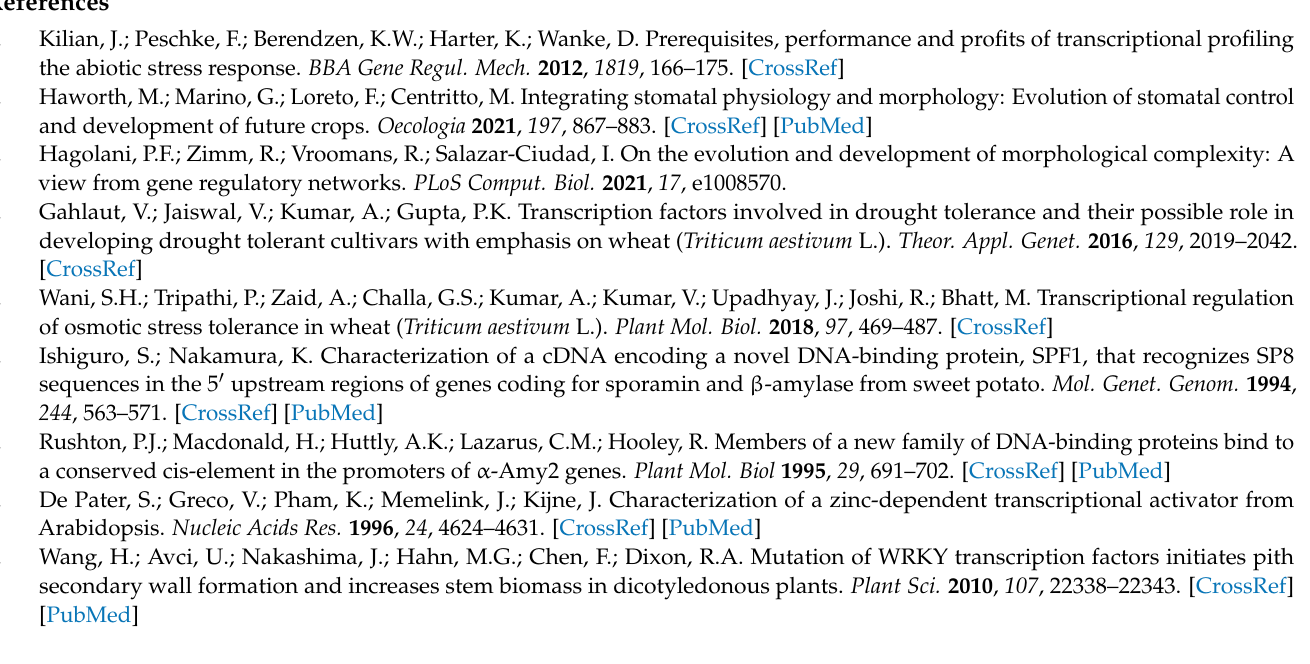
and III. Figure S2. Sequence logo of motifs in AsWRKY proteins. Figure S3. Chromosomal distribution of AsWRKY genes in oat. Bar plots indicate the number of AsWRKY genes in chromosomes, and broken lines represent AsWRKY gene density of each chromosome in oat. Figure S4. Frequency distribution and average number of Ka/Ks ratios. (A) Frequency distribution of Ka/Ks. (B) Average of Ka/Ks in AsWRKY subgroups. Figure S5. Gene Ontology of AsWRKY proteins. Figure S6. The flow chart of methodology. Table S1. qRT-PCR primers of AsWRKY genes. Table S2. Information of 162 AsWRKY genes. Table S3. Sequence feature of 162 AsWRKY genes. Table S4. SSR site prediction of WRKY genes. Table S5. Mapping data of AsWRKY genes. Table S6. Segmental and tandem duplications of AsWRKY gene pairs in oat. Table S7. Synteny analysis between A. sativa and other species. Table S8. Gene Ontology of 162 AsWRKY proteins. Table S9. miRNA-AsWRKY prediction. Table S10. Expression pattern of 162 AsWRKY genes under various